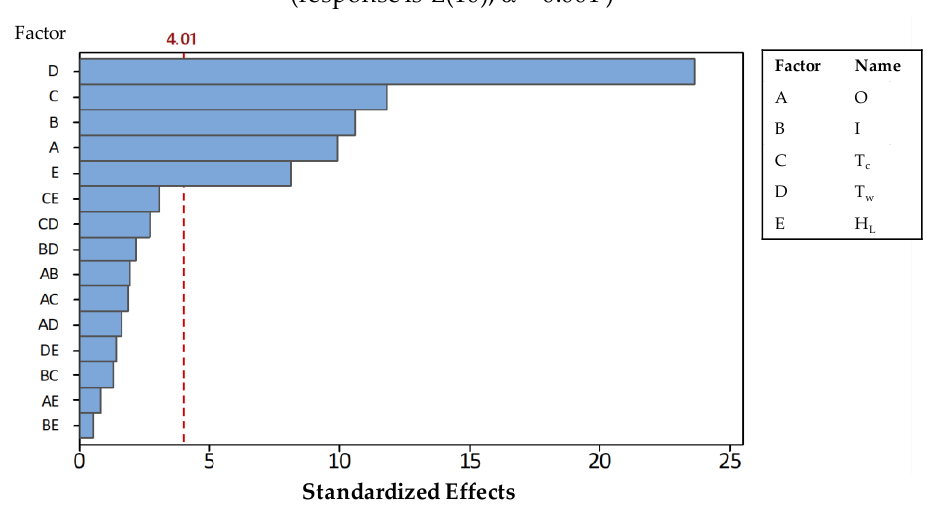
Figure 7. Pareto chart of the standardized effects.